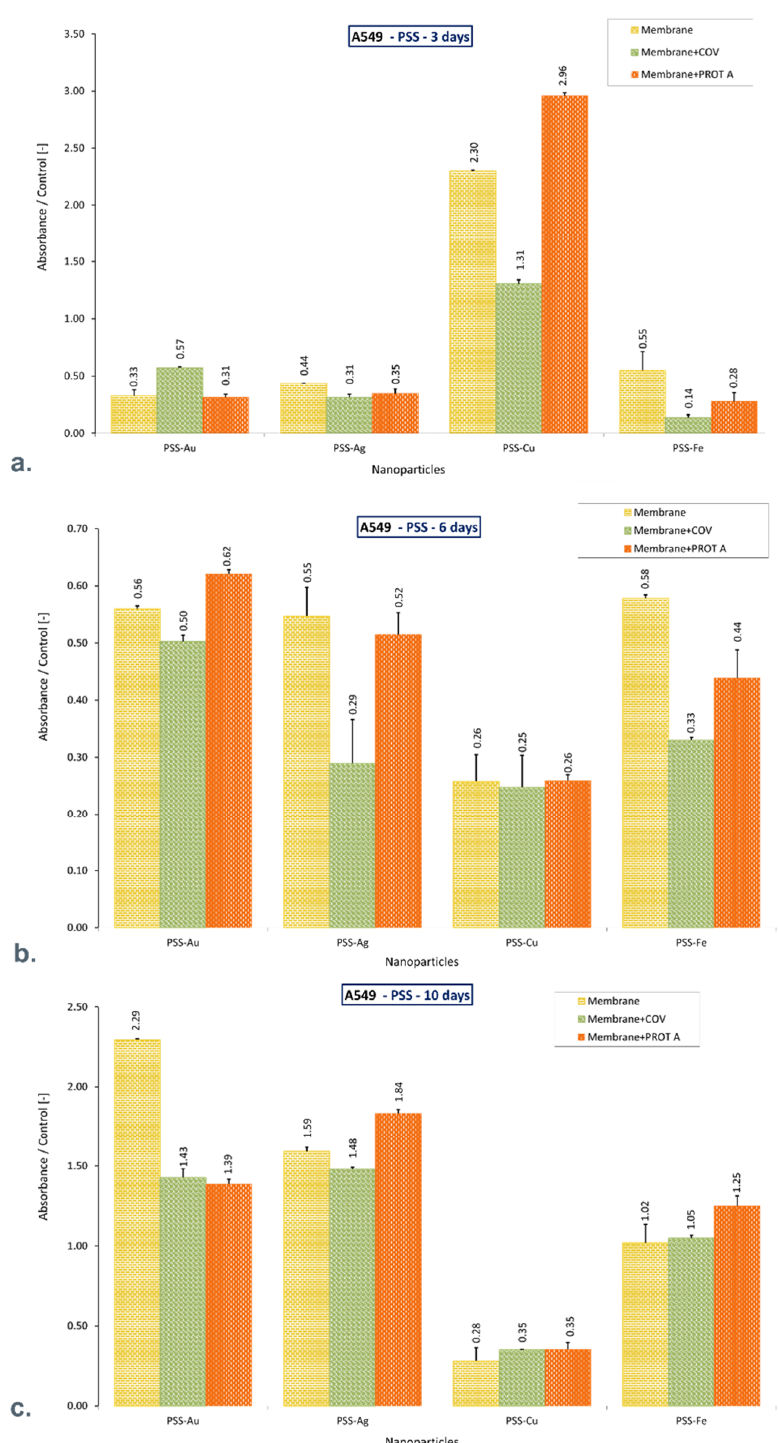
Figure 5. The ratio of the mitochondrial activity of A549 immobilized on membranes represented by formazan production expressed by absorbance to the control after ( a ). 3-day culture, ( b ). 6-day culture, ( c ). 10-day culture. The values are presented as mean ± SD. Key to the symbols: polystyrene sulfonate membrane with AuNPs incorporated (PSS-Au), polystyrene sulfonate membrane with AgNPs incorporated (PSS-Ag), polystyrene sulfonate membrane with CuNPs incorporated (PSS-Cu), polystyrene sulfonate membrane with FeNPs incorporated (PSS-Fe). Membrane—the membrane without adsorbed COV or PROT A; Membrane + COV—membrane with adsorbed COV; Membrane + PROT A—membrane with adsorbed Protein A.